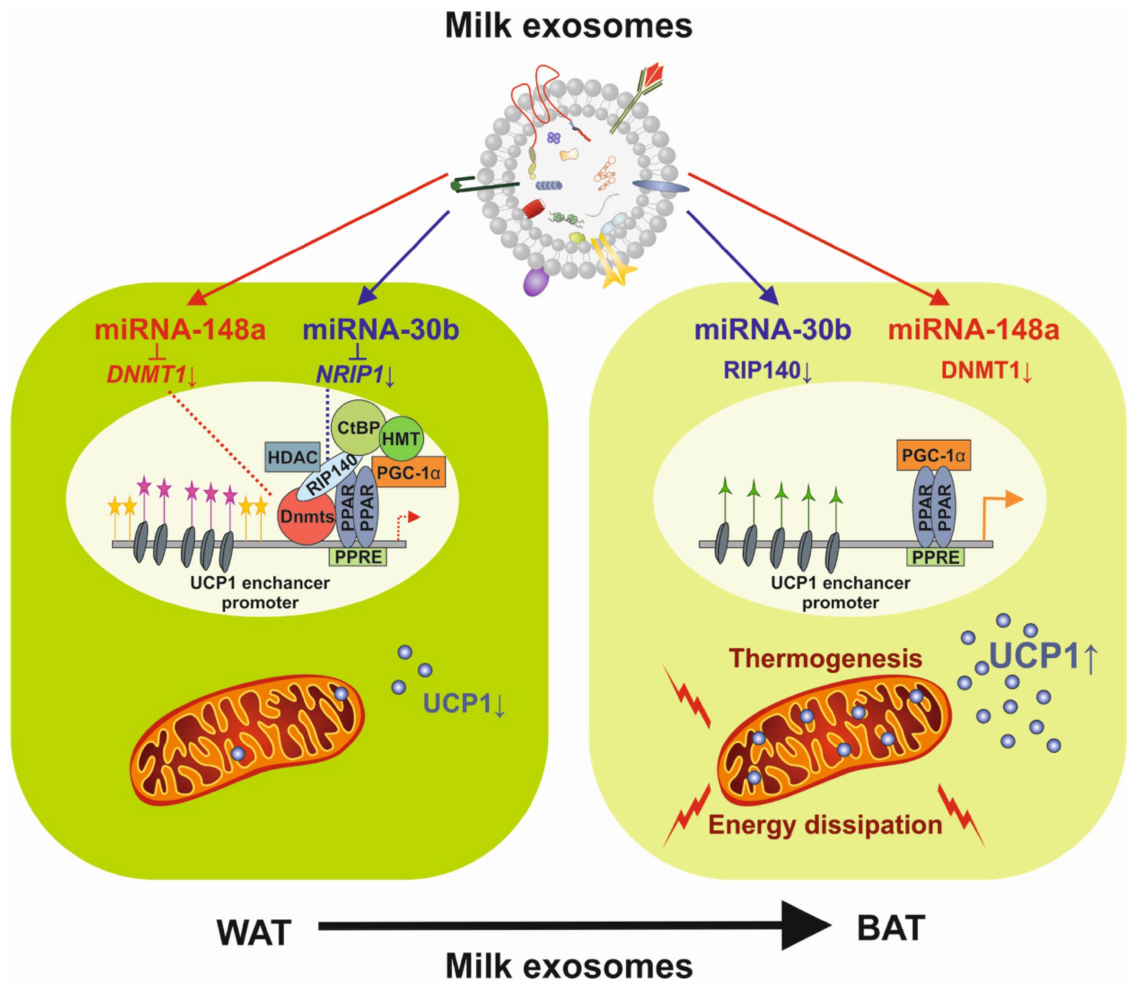
Figure 4. Potential impact of milk exosome-derived miRNA-148a and miRNA-30b on the expression of uncoupling protein 1 (UCP1). miRNA-148a inhibits DNA methyltransferase 1 (DNMT1) and miRNA-30b directly targets the mRNA of NRIP1 encoding receptor-interacting protein 140 (RIP140), activating the enhancer/promoter of UCP1 and increasing UCP1 expression, which drives thermogenesis and the conversion of white adipose tissue (WAT) into brown adipose tissue